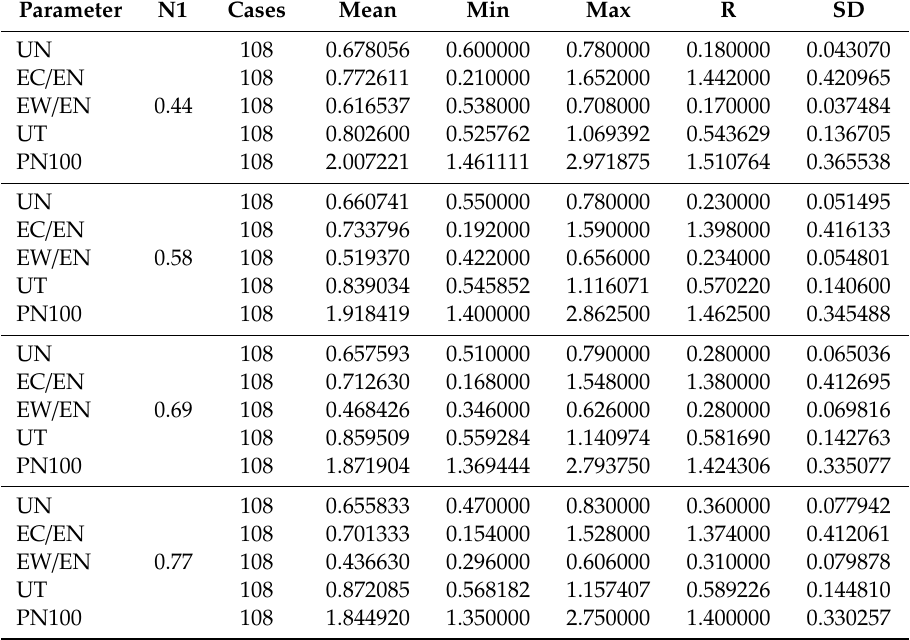
Table 6. Variation of lighting parameters for each luminaire downward luminous intensity distribution (N1